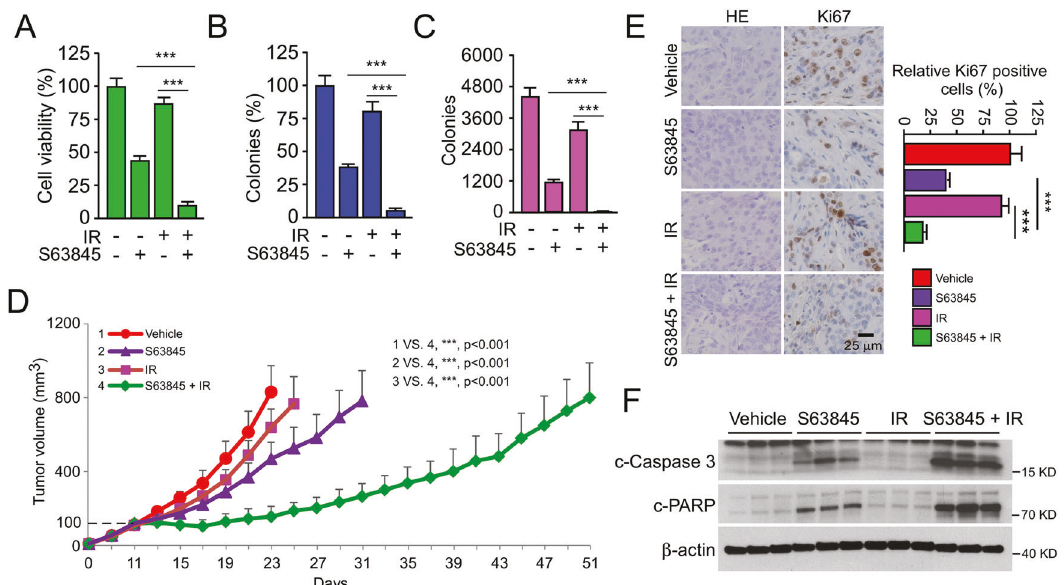
Fig. 8 Inhibiting MCL-1 overcomes radioresistance of OSCC in vivo. A – C CAL27R cells were treated with S63845 inhibitor (2 µM), IR (2 Gy) or a S63845/IR combination for 48 h. MTS assay was used to determine the cell viability ( A ), plate colony formation assay to analyze the colony formation ( B ) and soft agar assay to assess the anchorage-independent cell growth ( C ). D , E Xenograft tumors derived from CAL27R cells were treated with vehicle control (0.5% DMSO in Corn oil, 100 µL/every 2 days, i.p.), S63845 (5 mg/kg/ in 100 µL Corn oil every 2 days, i.p), IR (2 Gy/